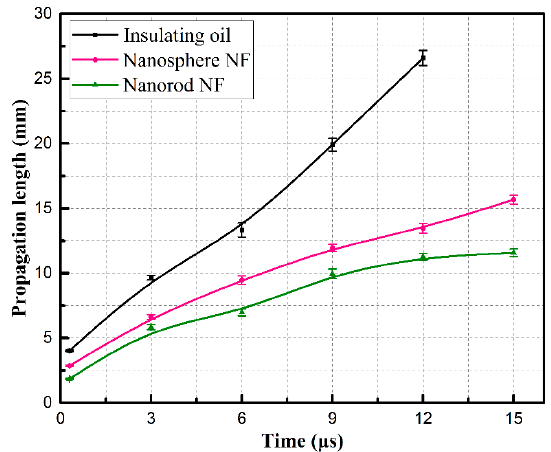
Figure 6. Positive streamer propagation length in insulating oil and nanofluids versus propagation times.